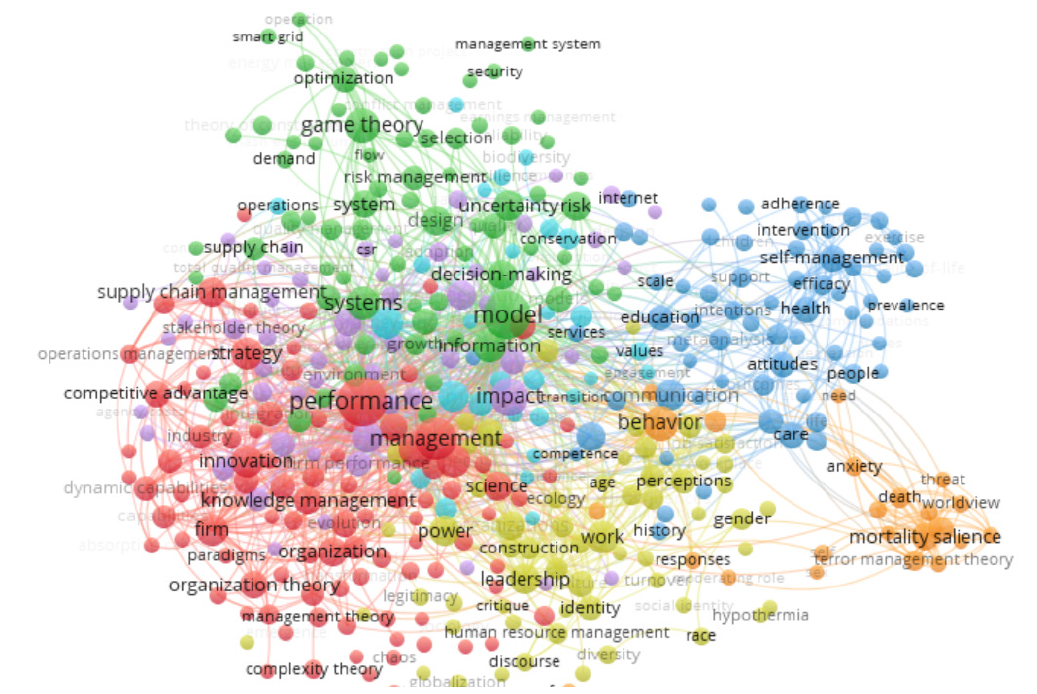
Figure 6. Keyword co-occurrence